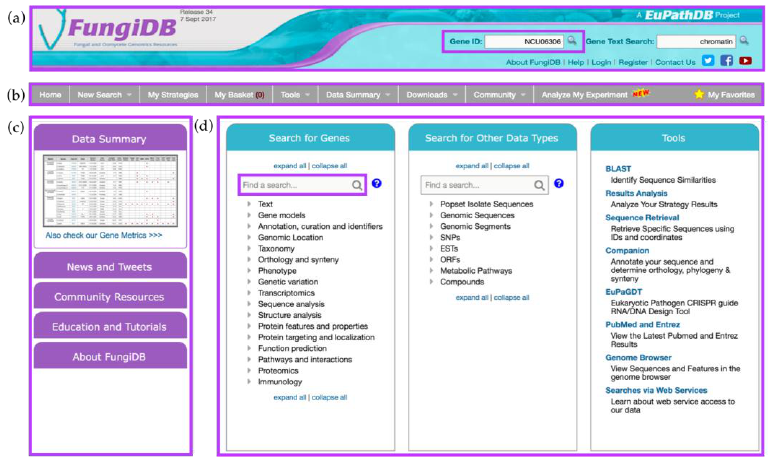
Figure 1. FungiDB Home page and its features. The home page comprises ( a ) the header section with Gene ID search highlighted in purple; ( b ) the main menu in grey; ( c ) the side bar with links and various information sections; and ( d ) the main component offering Search for Genes , Search for Other Data Types , and Tools sections. Find a search box from Search for Genes component is highlighted in purple.